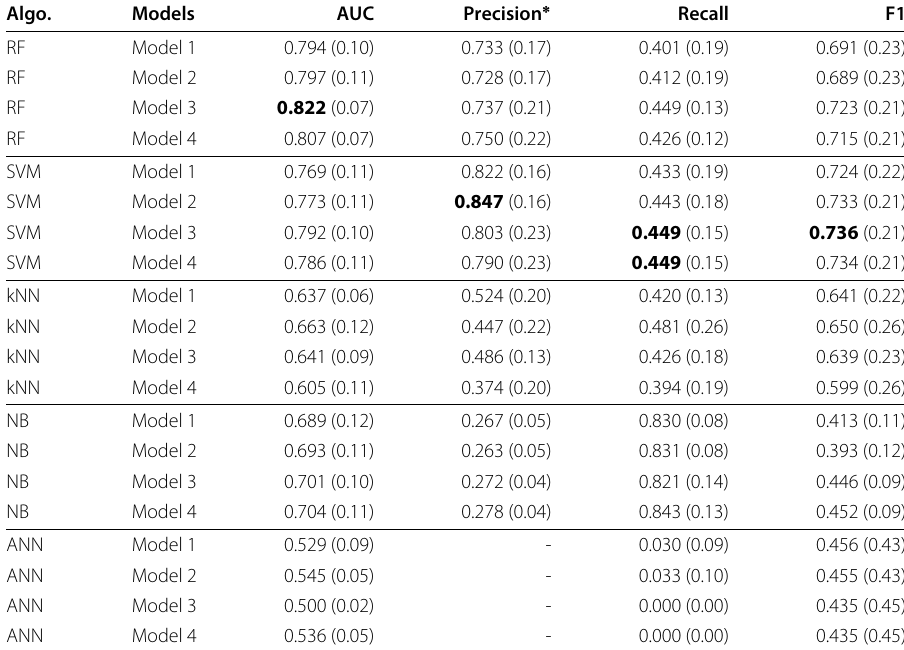
Table 3 Mean and standard deviation of prediction performance for heat pump existence with different machine learning algorithms (Data: ISO week 10, 2020)